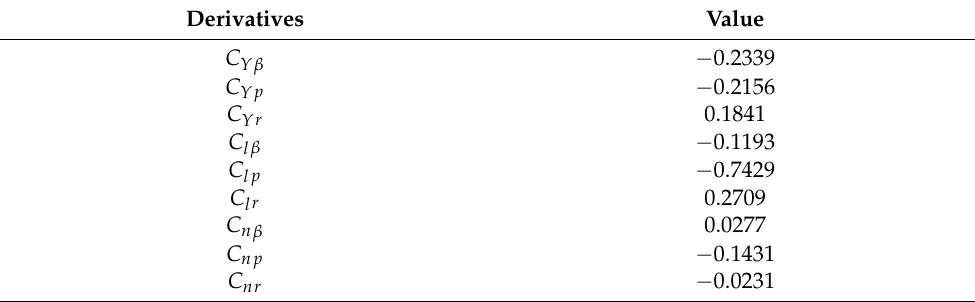
Table 9. Lateral derivatives of aerodynamic